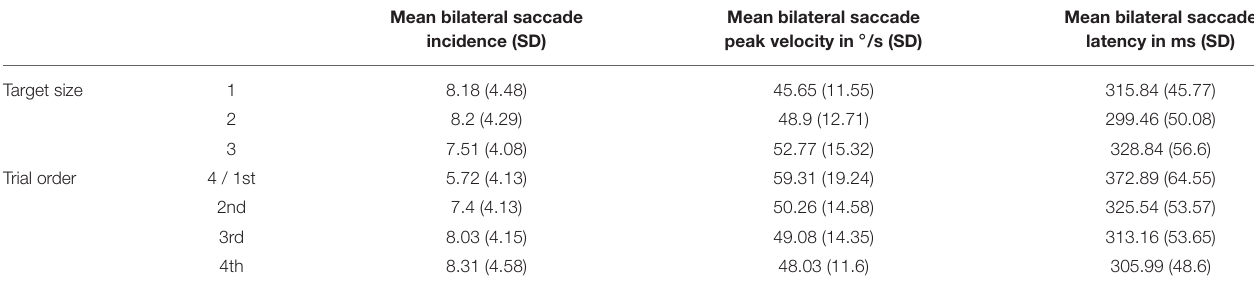
TABLE 3 | Mean bilateral saccade metrics for target size and trial